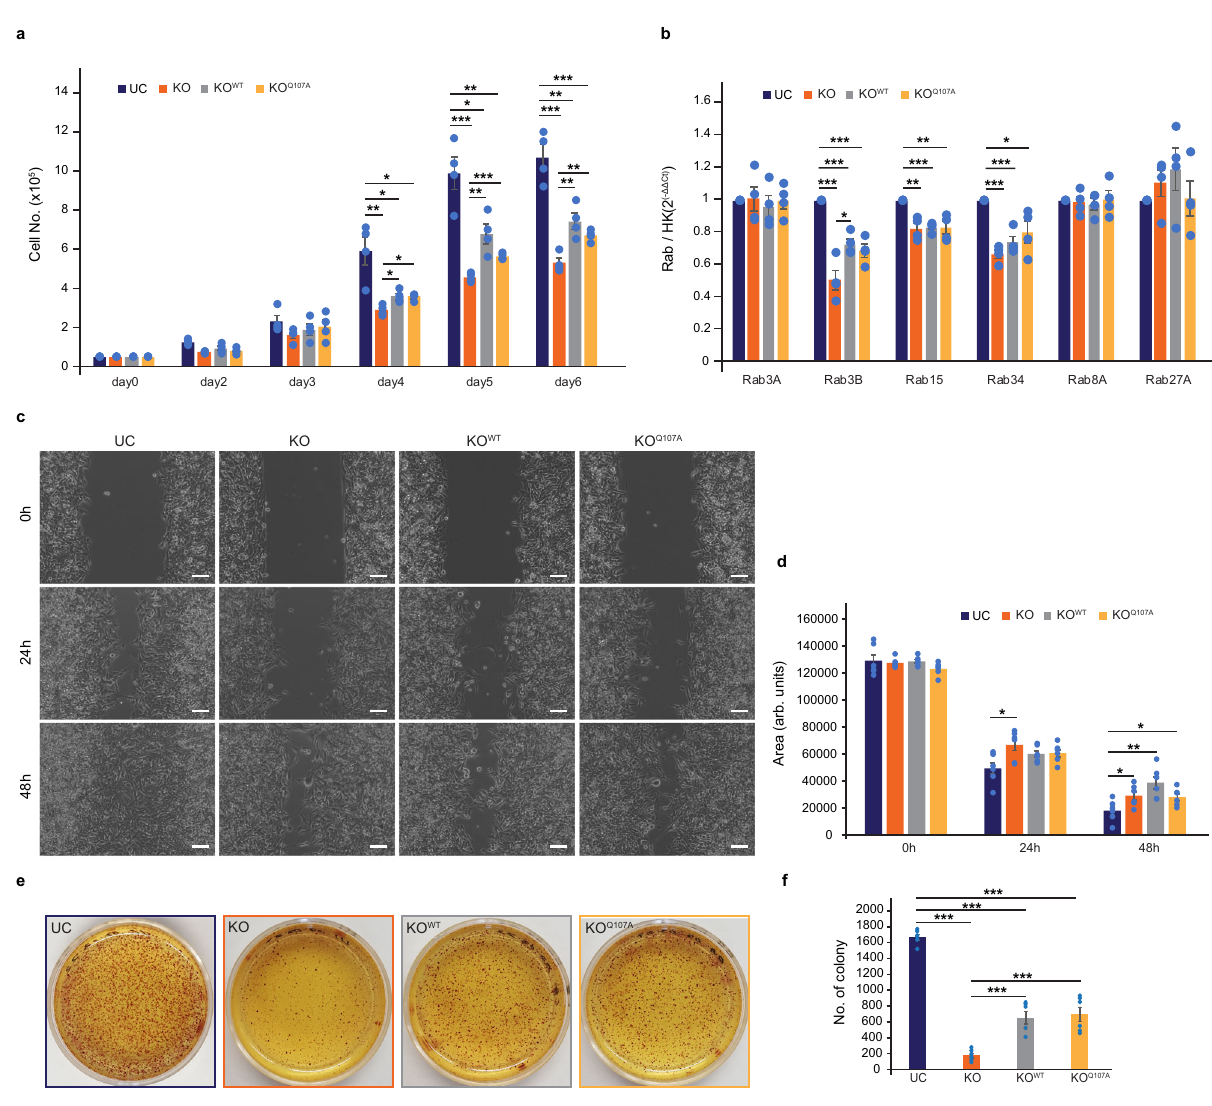
Fig. 8 Rep15 KO U138MG cells show reduced cell proliferation, migration and anchorage-independent growth. a Rep15 KO cells (orange bars) show a signi fi cant reduction in cell proliferation as measured by counting the number of cells for six days. Both the rescue cell lines (KO WT (gray bars) and Rab- binding de fi cient mutant KO Q107A (yellow bars) showed a signi fi cant increase in the cell proliferation over the knockout background ( n = 4). b Real-time quantitative PCR analysis of the KO for the Rep15 indicates a signi fi cant reduction in the mRNA expression of Rab3B, Rab15 and Rab34, while the expression of Rab3A, Rab8A and Rab27A remain unchanged. The expression of measured Rabs in the two rescue cell lines did not look different from the KO cells, except in the case of rescue with the WT-Rep15 (KO WT ), for Rab3B ( n = 4). c Rep15 KO cells show a reduced cell migration in a 2D scratch assay, with no signi fi cant difference in the two rescue cell lines (representative picture; 10× magni fi cation). Scale bar, 100 µ m. d Quanti fi cation of the 2D scratch assay ( n = 6). e The KO cells show a reduced capacity to form colonies in the anchorage-independent growth, with the signi fi cant rescue with both the WT and Q107A mutant (representative picture). f Quanti fi cation of the number of colonies counted in e ( n = 6). Data are presented as mean value ± SEM. * p < 0.05, ** p < 0.01, *** p < 0.001, (unpaired, two tailed, Student ’ s t -test). Source data are provided as a Source Data fi le. n represent the biological repeats. The exact p values are provided in the Source data fi overexpressed the GFP-tagged WT or Q107A mutant in KO cells and measured transferrin recycling. The cells were grouped under low and highly-GFP expressing cells, with only the low-GFP cells showing rescue, while the highly-GFP expressing cells failed to rescue the recycling defect, further validating the fact that strong overexpression of WT Rep15 had an adverse effect on the recy- cling pathway even in the KO background (Supplementary Fig. 14a, b). The transient overexpression of the mutant did not look different from the KO cell line (Supplementary Fig. 14b). Further, we transiently overexpressed the GFP-tagged WT and Q107A mutant in the WT cells, the overexpression of WT Rep15 (UC WT ) signi fi cantly reduced the recycling pathway while Q107A